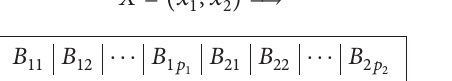
Table 2: Probability distribution of airport PAAR 𝛿